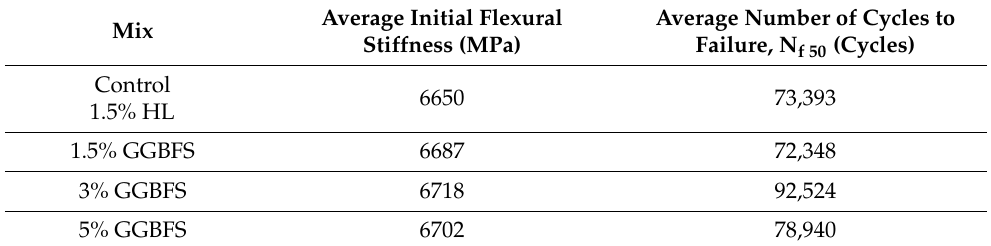
Table 10. Fatigue test results.